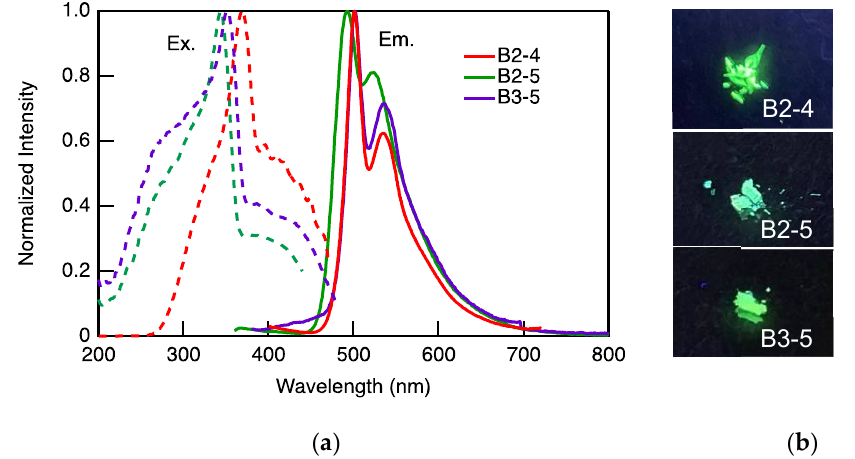
Figure 5. ( a ) Excitation (dashed line) and emission spectra (solid line) of gold(I) complexes in the crystal. The λ ex for emission spectra were shown in Table 3. Excitation spectra were obtained at the maximum wavelength for emission ( λ maxlum ) shown in Table 3. Red, B2-4 ; green, B2-5 ; purple, B3-5 . ( b ) Photographs of gold(I) complexes taken under 365 nm UV irradiation. Table 3. Photophysical parameters of gold(I) complexes in the crystal at room temperature. Complex